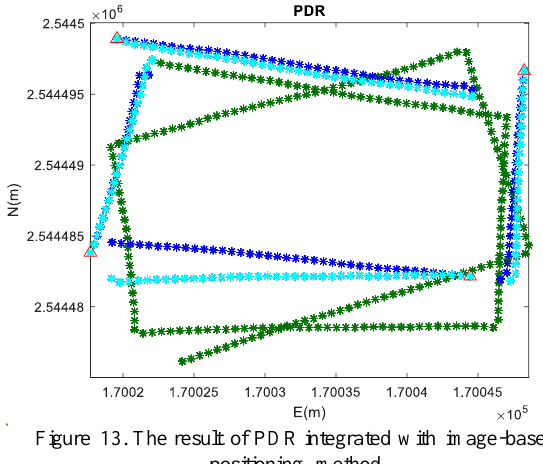
Figure 13. The result of PDR integrated with image-based positioning method The green one represents the trajectory only using PDR, which goes for two circles. The triangle at bottom left is the start point, and other three are the position updated by image-based